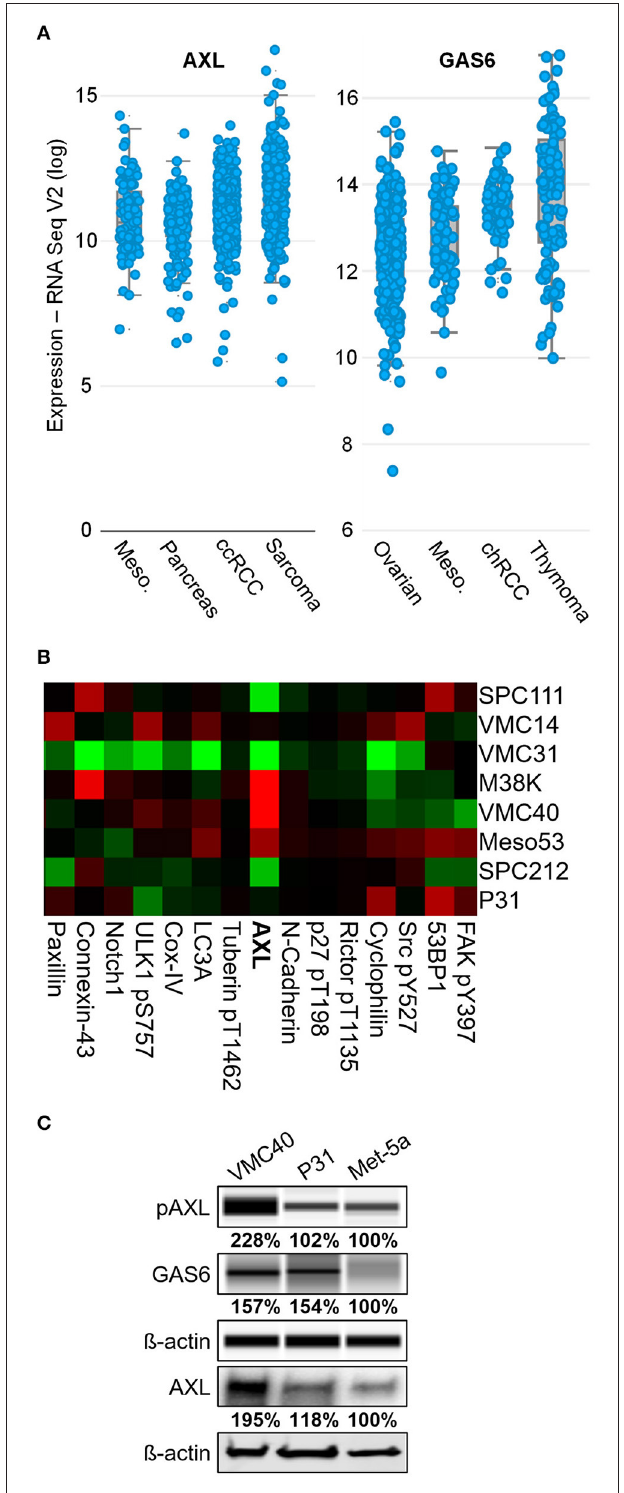
FIGURE 1 | AXL is abnormally expressed in MPM. (A) AXL and GAS6 expression are elevated in clinical MPM samples. Of 30 TCGA cancer datasets, MPM (87 samples, blue dots ) ranked fourth highest for AXL and thirdhighestforGAS6expression,andmeanlog 2 valueswere11.40and13.06,